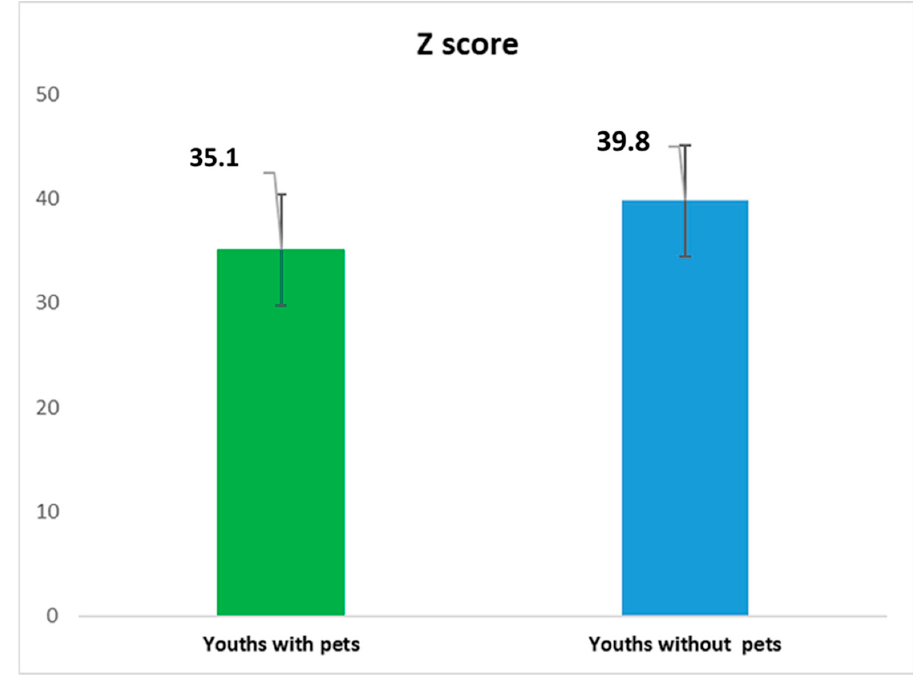
Figure 2. The Z score both for youth pet owners and for youths without pet.